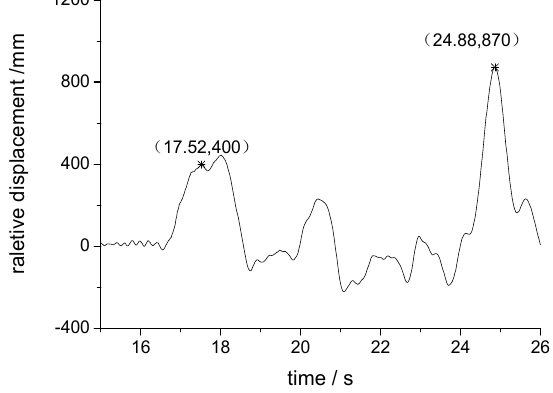
Figure 15. Time history curve of relative longitudinal displacement of the pier and the girder.